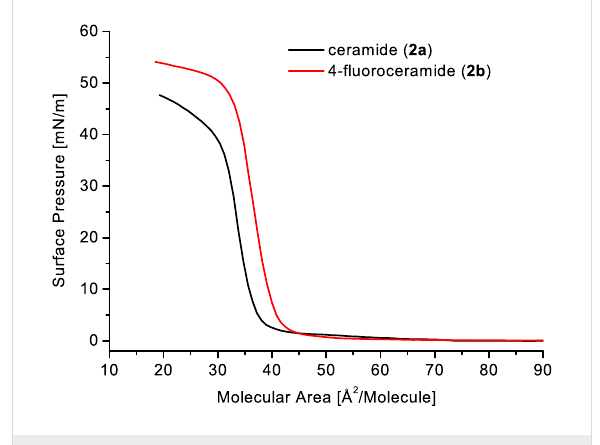
Figure 3: π–A Isotherms of ceramide ( 2a ) and 4-fluoroceramide ( 2b ) at 20 °C (80 cm 2 /min compression velocity).